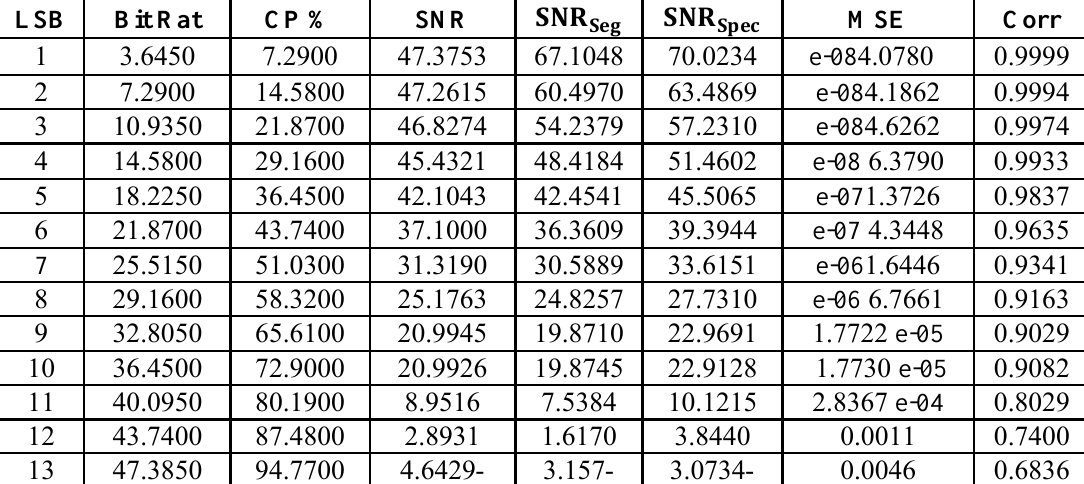
Table 1: Capacity calculation of the speech (T=4 min, F=8000 Hz, ch=1, B=16).